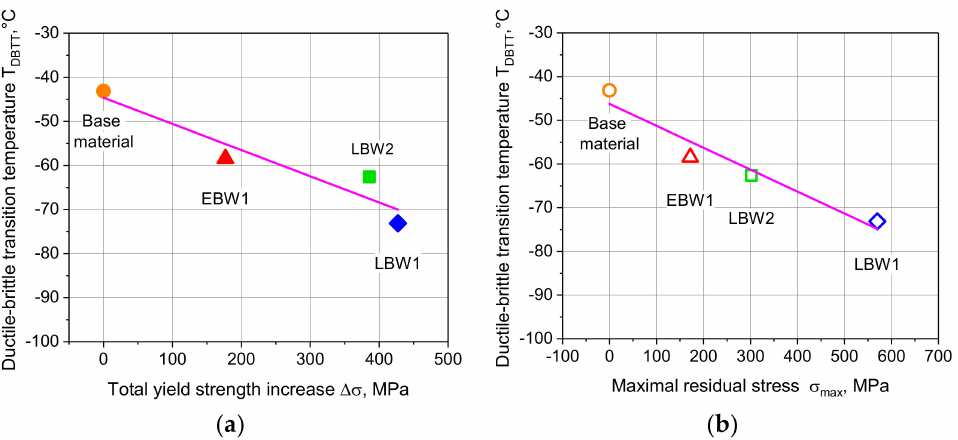
Figure 13. Ductile-brittle transition temperature T DBTT vs. total yield strength increase ∆ σ estimated at notch position ( a ) and vs. maximal residual stress at weld seam center ( b